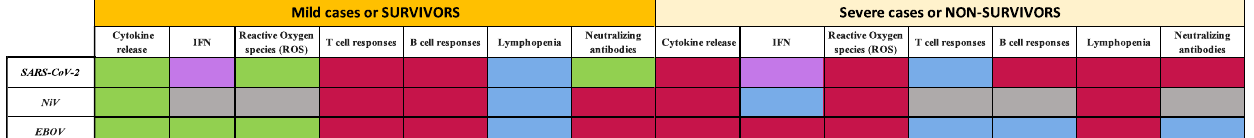
TABLE 1 Key features of immune responses to SARS-CoV-2, NiV and EBOV infecCon in